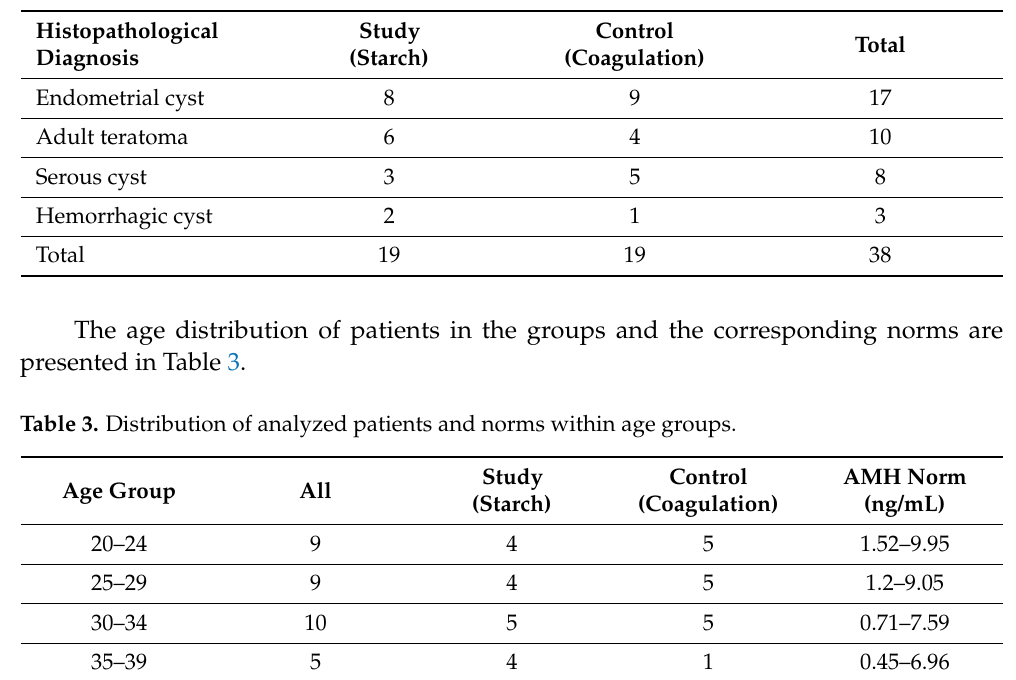
Table 2. Distribution of histopathological diagnoses in the analyzed groups.